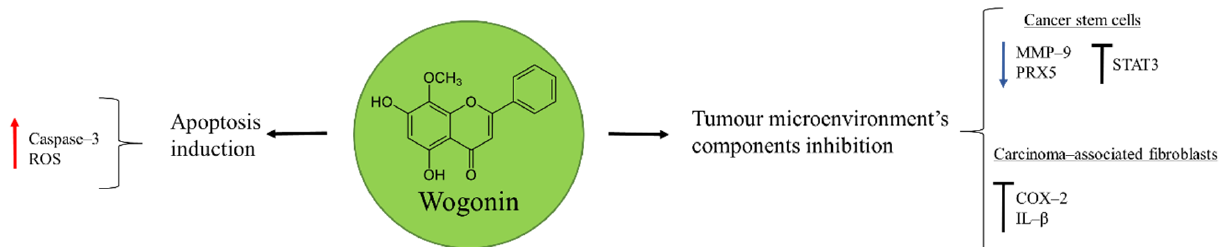
Figure 2. Wogonin in osteosarcoma inhibition.